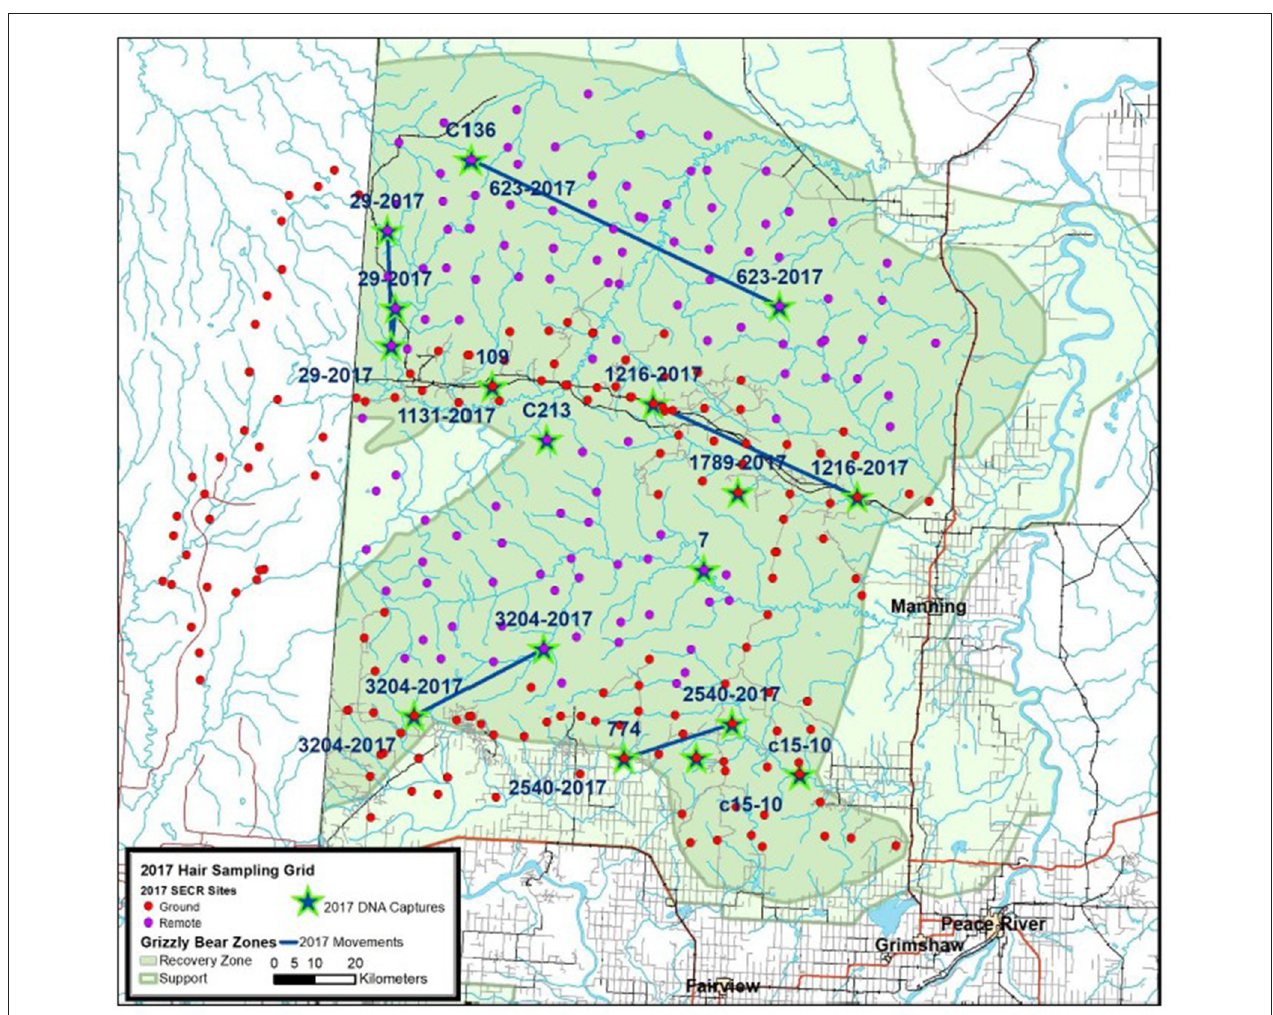
FIGURE 3 | Spatial configuration of the hair snare sampling grid and grizzly bear detections across BMA 1 Recovery Zone and along the British Columbia border. Labels indicate the ID number of detected grizzly bear individuals and associated movements between hair snare